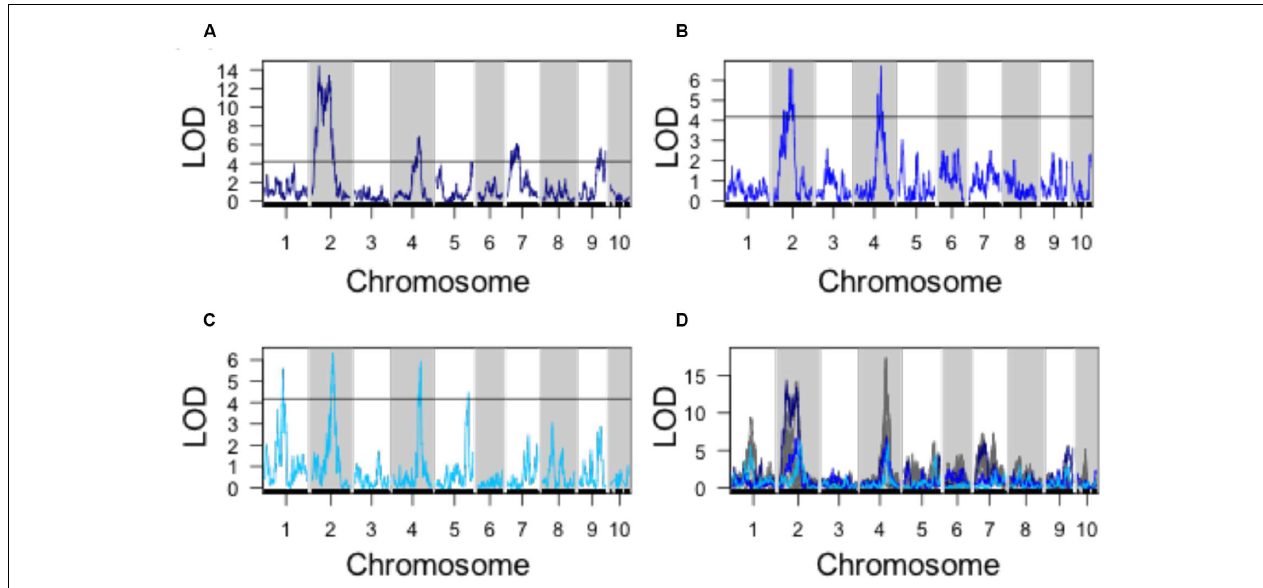
FIGURE 4 | QTL identified for discreet cosine transform PCs. (A) QTL for PC1. (B) QTL for PC2. (C) QTL for PC3. (D) Superimposed QTL profiles for discreet cosine transform descriptors (blues) and parabolic estimator phenotypes (gray). Black line, significance threshold a = 0.05.